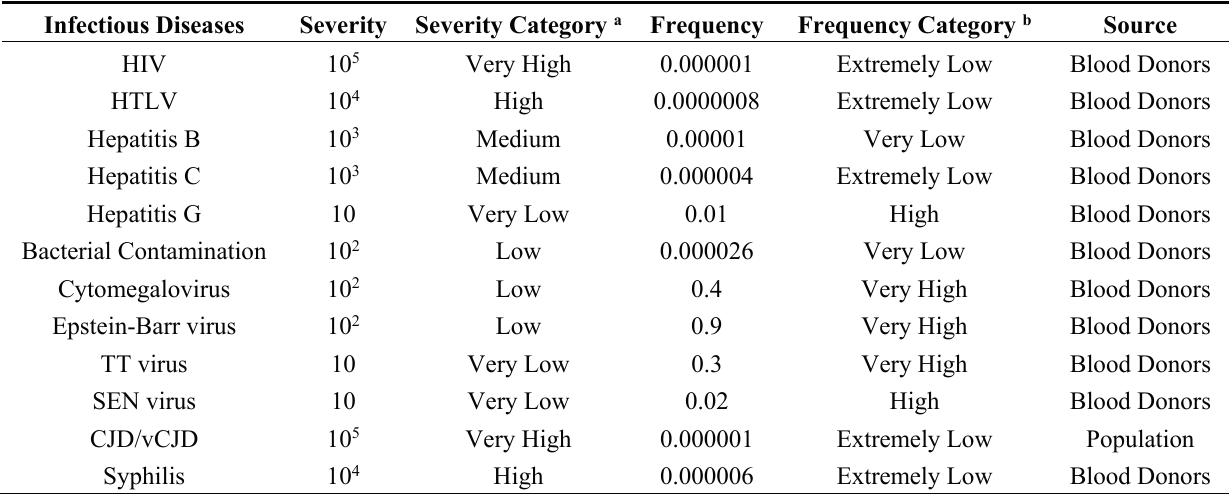
Table 2. Severity and frequency of blood infectious diseases in Canada, 1987–1996, adapted from [13]. Infectious Diseases